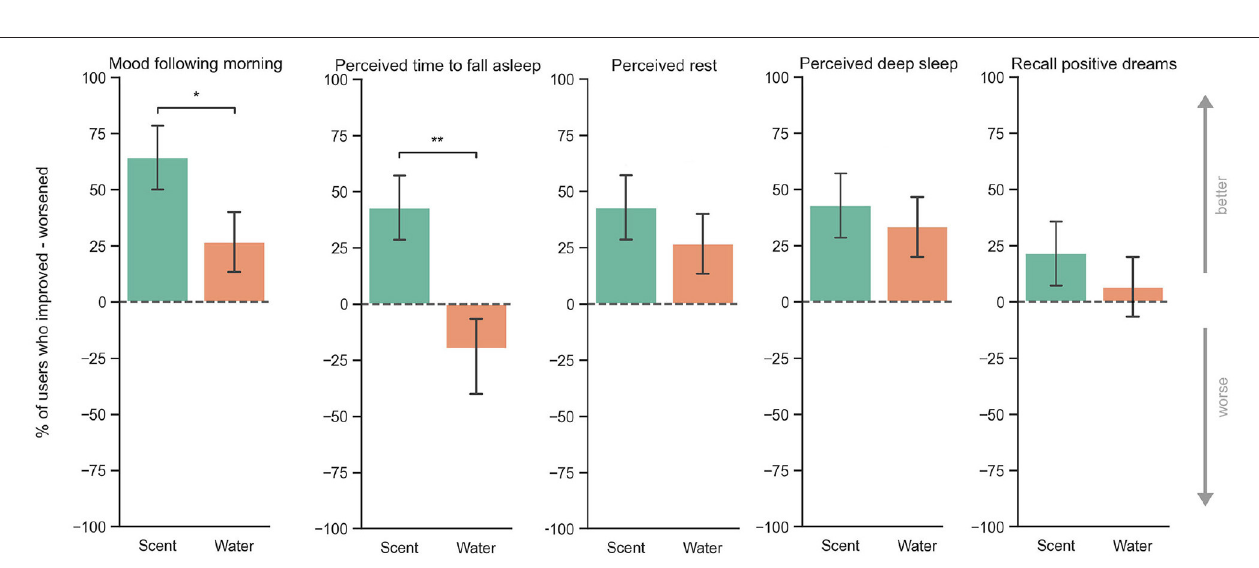
FIGURE 8 | Answers to the questions “How aware were you of the prototype?”; 7 = Very unaware, 1 = Very aware, a neutral response is a 4. “How aware were you of the scent?" and “Did you wake up because of the prototype?” Ninety-three percent of participants that were in the control condition and 78% in the scent condition reported not waking up because of the prototype. ** P < 0.01.